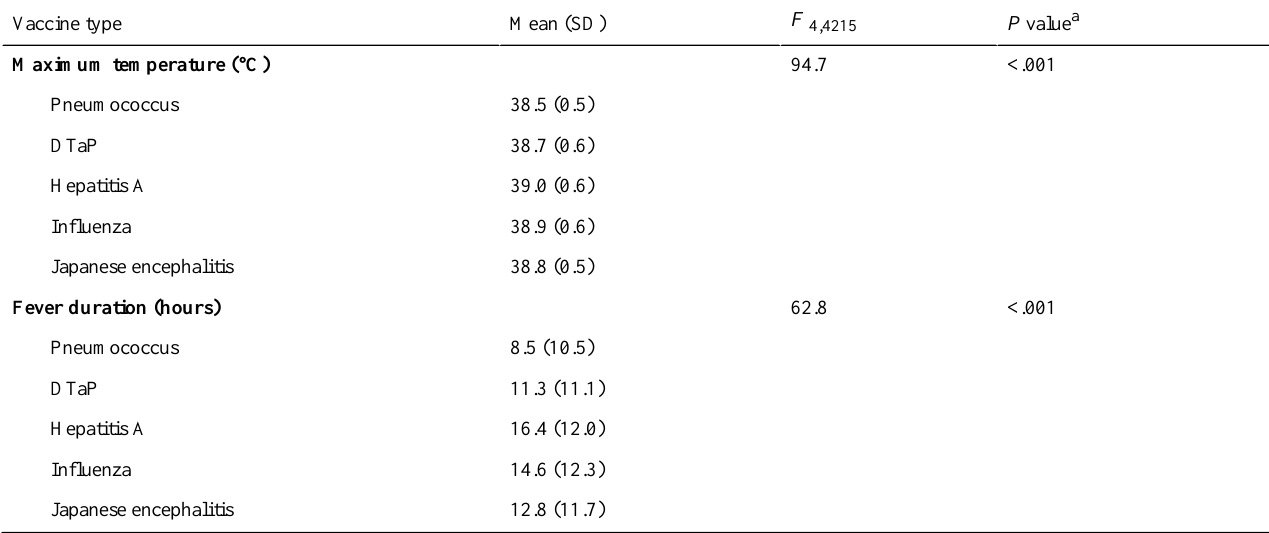
Table 2. Comparison of maximum temperature and fever duration among vaccine